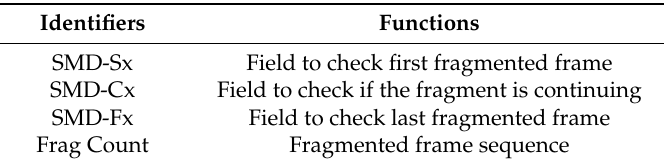
Figure 4 . IEEE 802.1Qbu frame format.